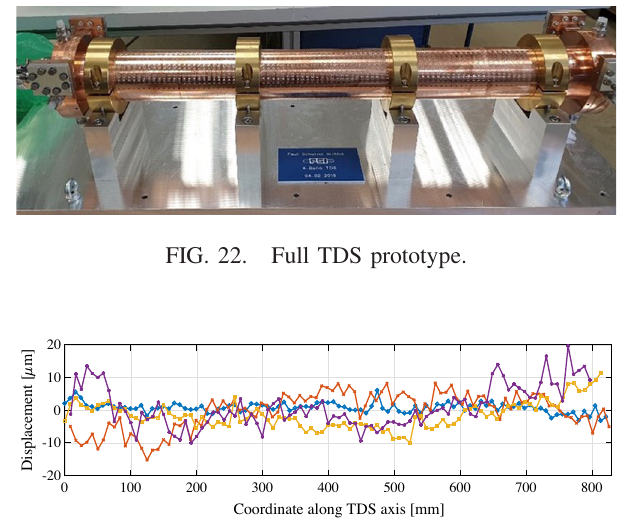
FIG. 24. Measured insertion loss and reflection coefficient (left) and sketch of the measurement setup